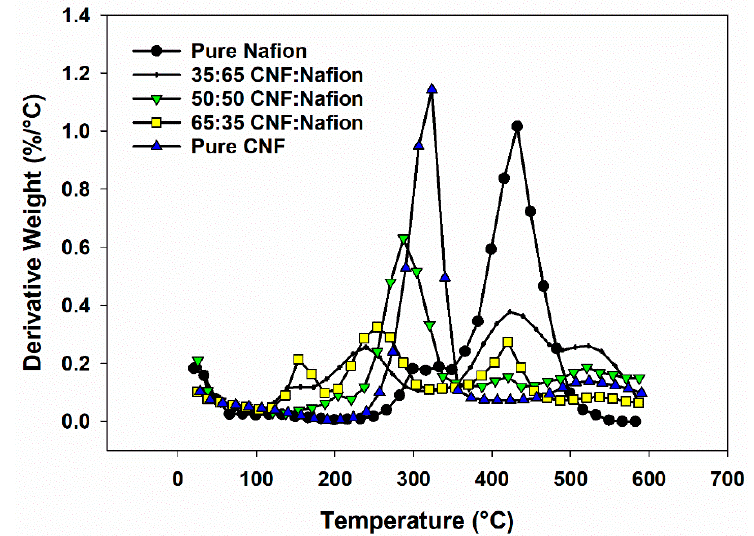
Figure 5. Derivative thermogravimetric (DTG) profiles of the same membranes: Nafion ® , CNF and hybrids of Nafion ® in nitrogen atmosphere.